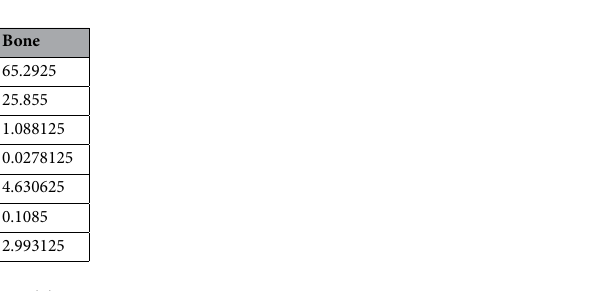
Table 2. Tissue mimicking material